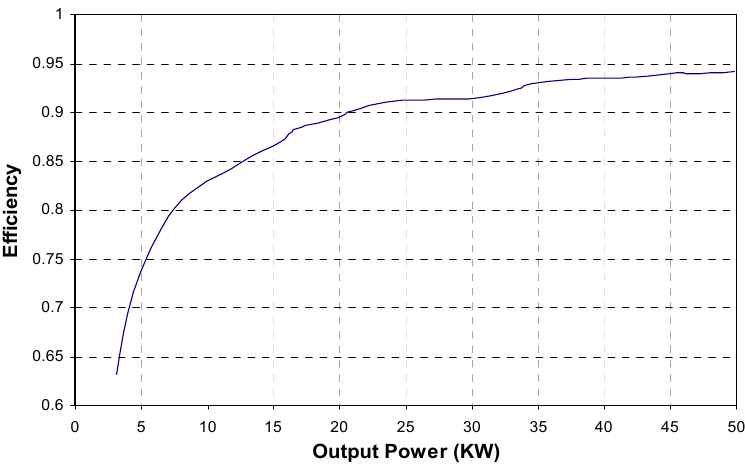
Figure 3. Rectifier efficiency